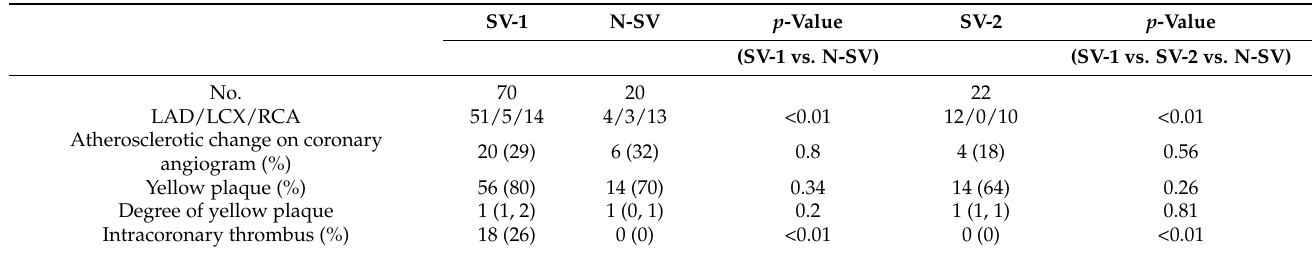
Table 4. Frequencies of atherosclerosis, yellow plaque and intracoronary thrombus in all vessels.